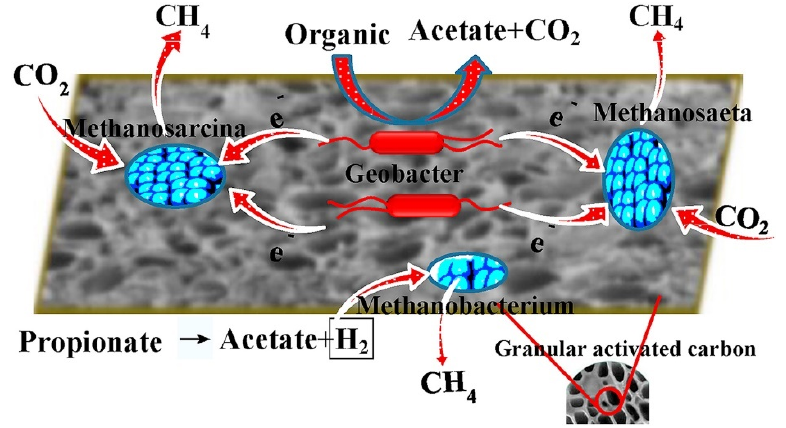
Figure 3. Mechanism for granular carbon in enriching the hydrogen-utilizing methanogens, Geobacter and other methanogens capable of direct interspecies electron transfer, to accelerate the methane generation and sludge consumption [16].